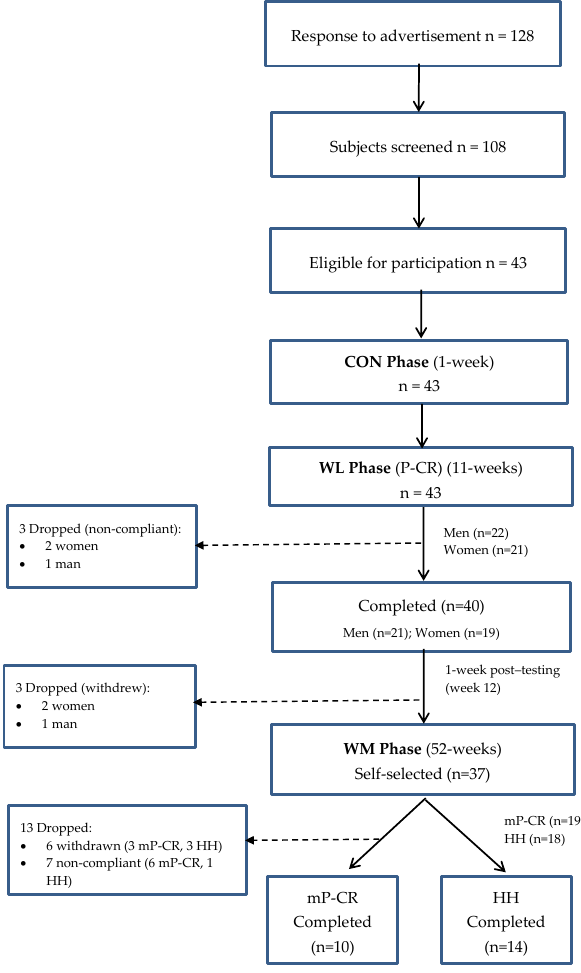
Figure 1. CONSORT of Participant Flow